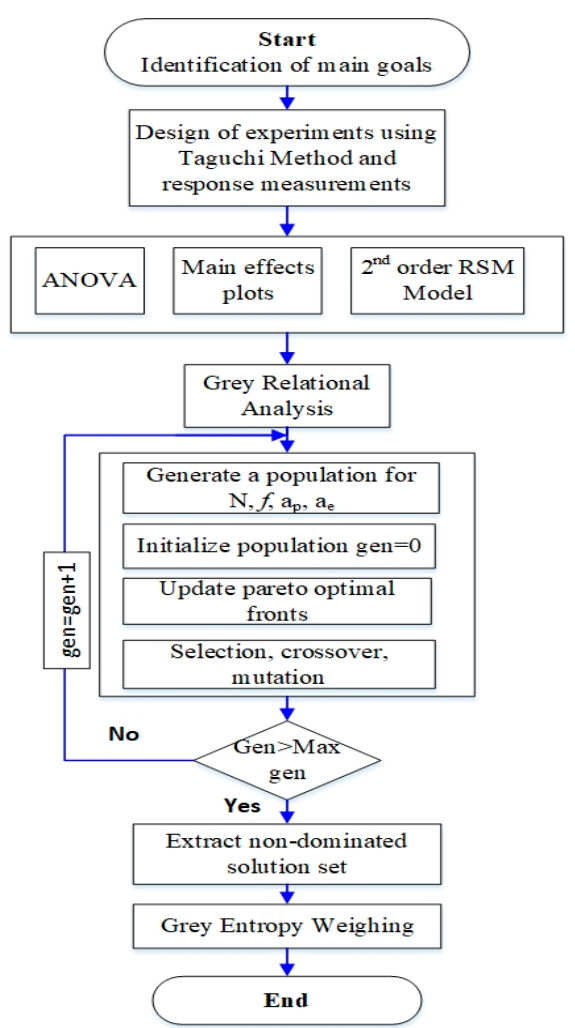
Figure 7. Flow chart of the milling process optimization algorithm with GRA Coupled with theNon-Dominated Sorting Genetic Algorithm (NSGA-II).